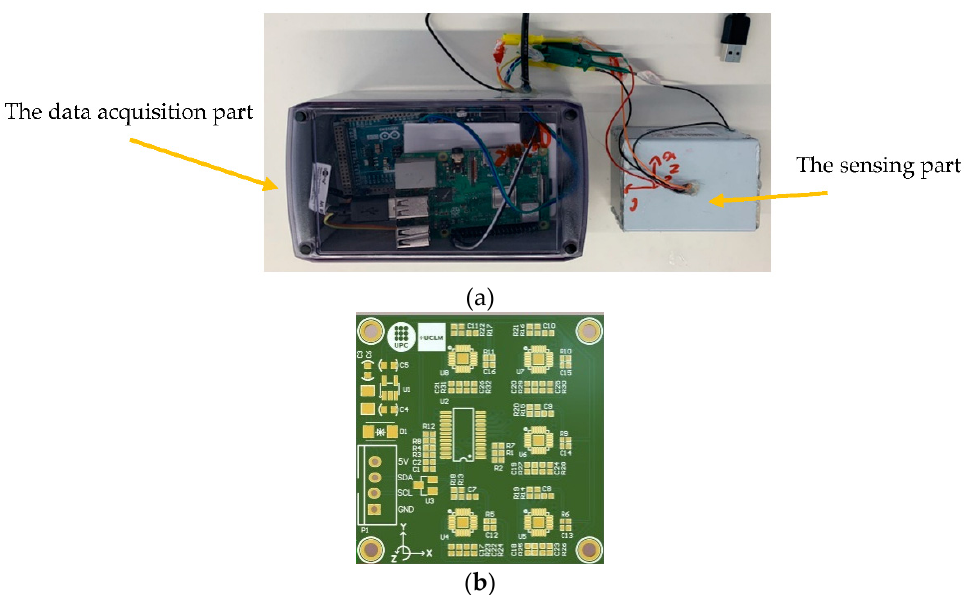
Figure 1. LARA: ( a ) boxed sensing part and data acquisition part of LARA, and ( b ) PCB design of LARA.